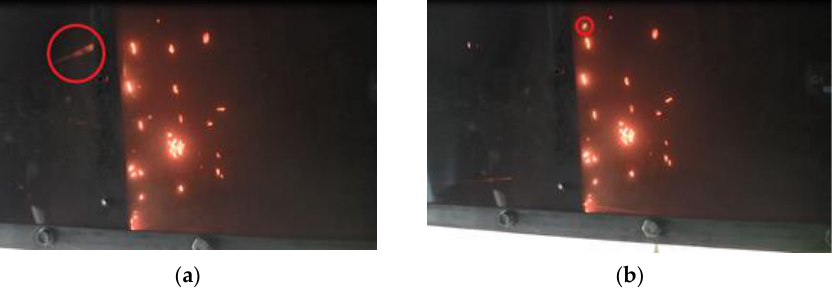
Figure 16. Deceivingly large firebrands at the exit side of the mesh taken by a camera with a speed of 250 frames per second ( a ) a firebrand with an apparent cross-section greater than the opening of the mesh at the exit of the mesh, and ( b ) the previous frame shows the of the actual needle shape of the firebrand in a). (Stainless Steel Wire and Mesh Pty Ltd. [17]).